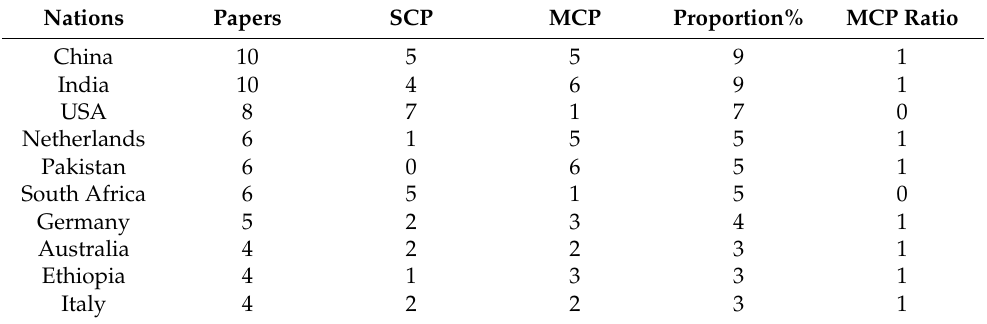
Table 5. The top ten most active countries by corresponding authors within the period 2009–2022.